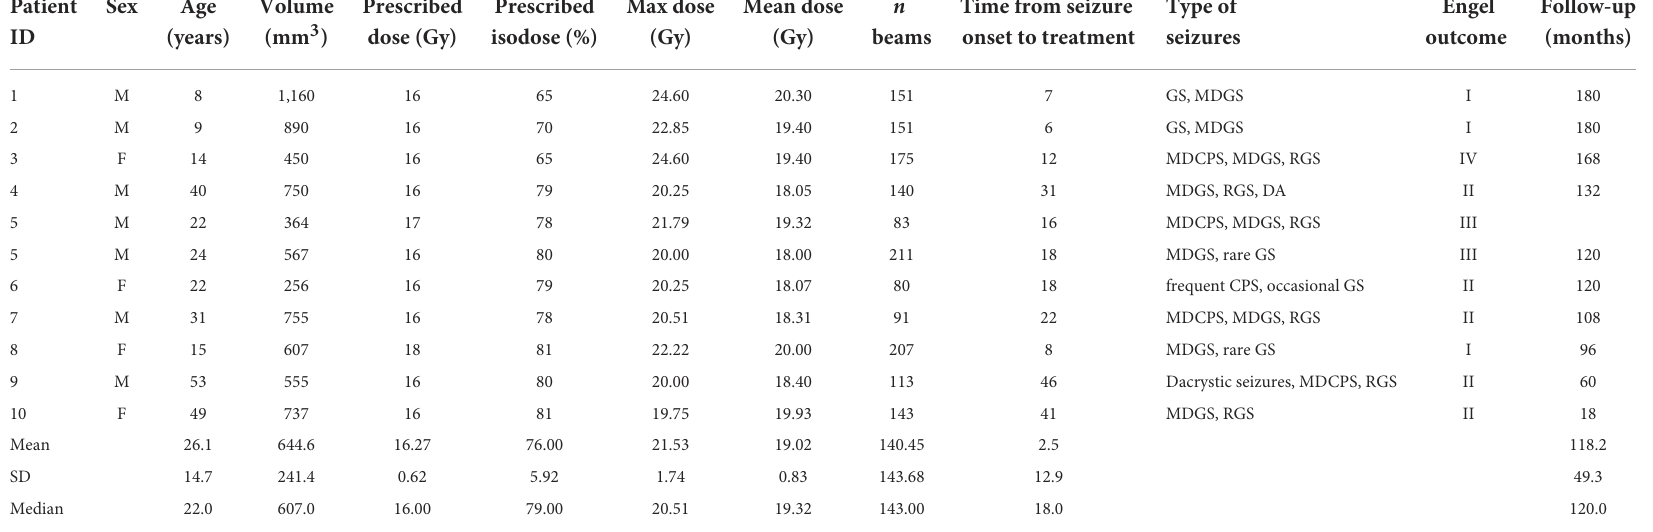
TABLE 1 Clinic characteristics of the